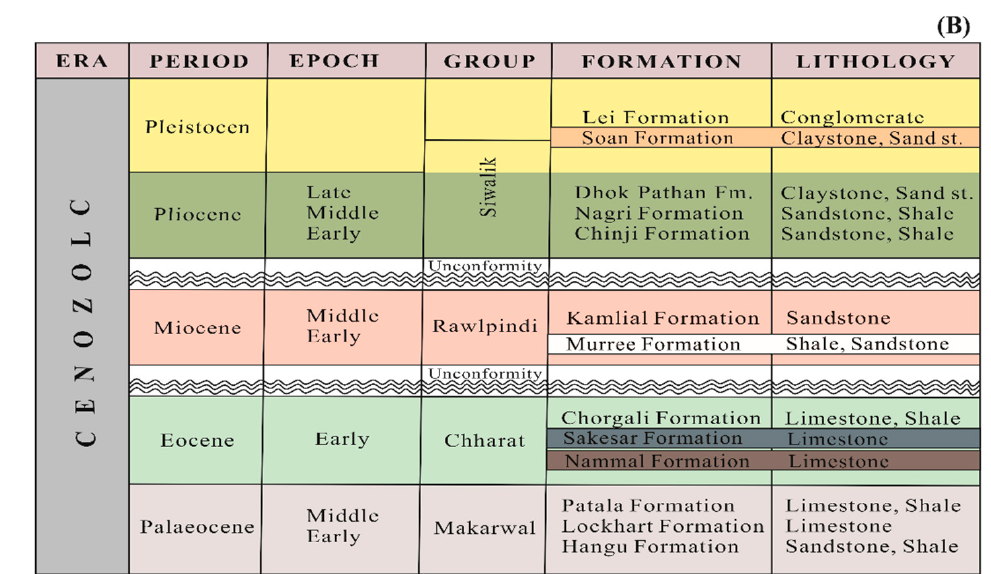
Figure 2. ( A ) Location map of the Uchhali complex, Soan–Sakesar Valley, Salt Range, Pakistan. The lithology of the study area is also reported (modified from [25,44,45]). ( B ) Stratigraphic column of the study area. The Sakesar and Muree formations represent the main water-bearing formations.